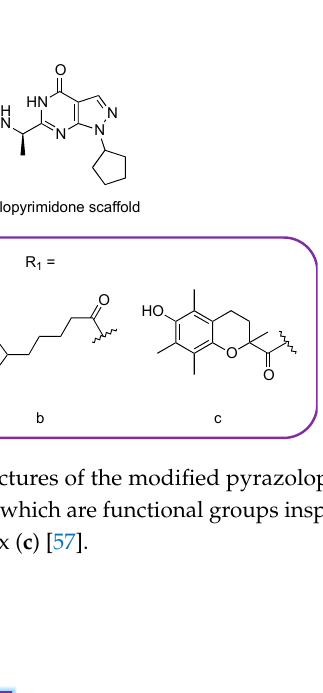
Figure 9. General structure of the xanthine scaffold. The positions that were modified in the abovementioned study have been marked with an arrow.